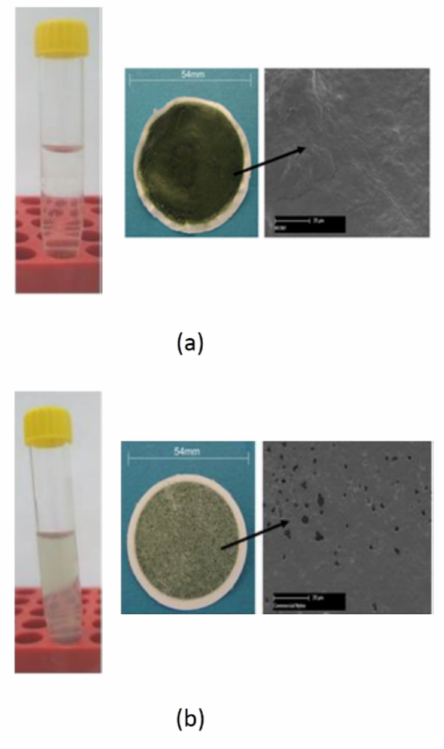
Figure 5. SEM images of the typical membranes after filtration and photographs of permeate using ( a ) an electrospun Nylon 6 membrane and ( b ) commercial Nylon membrane, respectively. Figure is adapted and modified from